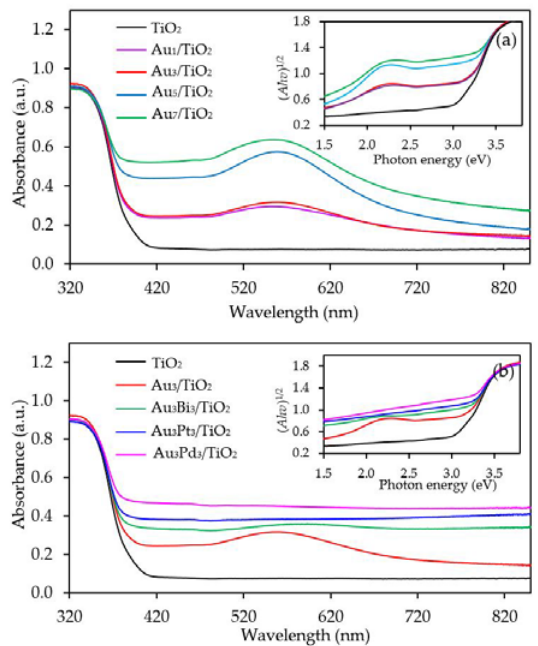
Figure 4. Representative ultra violet-visible (UV-Vis) spectra of the TiO 2 and different ( a ) Au x /TiO 2 and ( b ) Au 3 M 3 /TiO 2 photocatalysts with (insert) the respective Tauc’s plots.